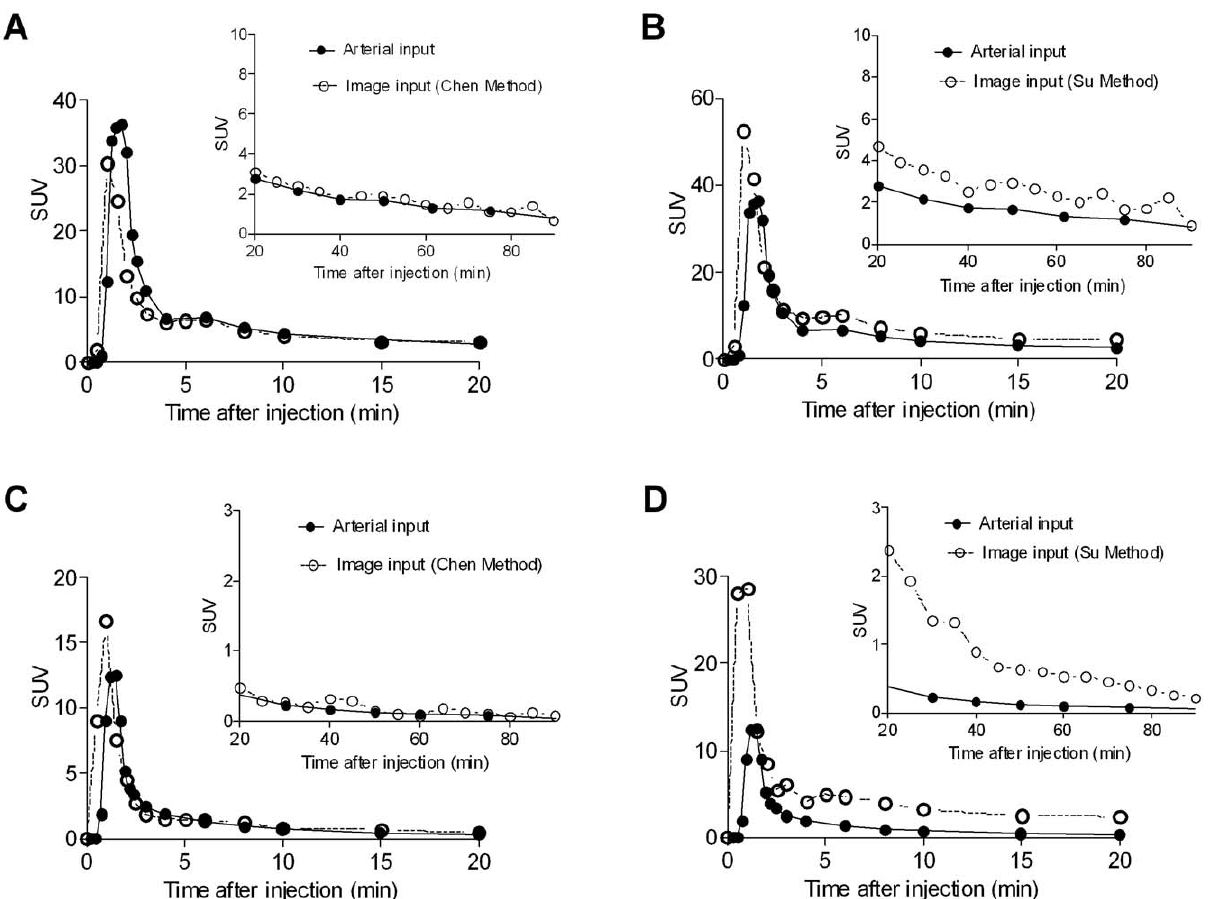
Figure 3. The concentrations over time of [ 11 C]( R )-rolipram (A and B) and [ 11 C]PBR28 (C and D) in plasma from the arterial input function (solid line) and from the image input function (dashed line) of a representative healthy subject. The curves are representative of those from a blood-based (Chen; A and C ) and a blood-free (Su; B and D ). None of the methods precisely estimated the peak in all the subjects but, in general, blood-based methods yielded a better estimate of the tails of the curves.